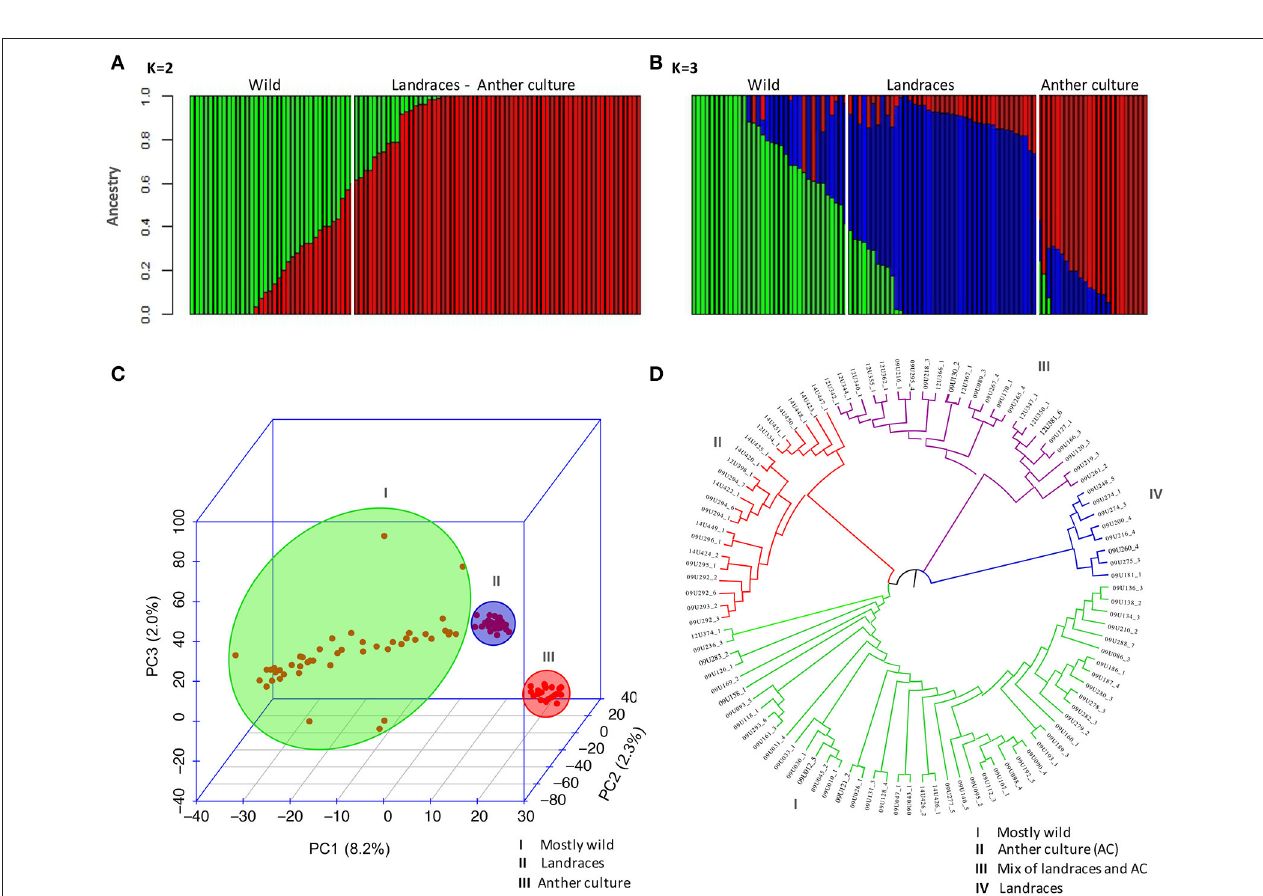
FIGURE 2 | Population structure of cape gooseberry collection based on 30,344 SNPs markers. Inferred population structure of the cape gooseberry collection using the tomato SNPs matrix. Bar plot for K = 2 (A) and K = 3 (B) grouped by state of cultivation and the bar length represent the membership probability of each accessions belonging to different sub-populations. (C) Scatterplot of Principal Component Analysis scores of components PC1, PC2 and PC3 based on 30,344 SNP markers. (D) NJ-based dendrogram with cape gooseberry SNPs clustered into four sub-populations. Colors correspond to each sub-population which consisted of: mostly wild accessions (I-green), mostly AC accessions (II-red), mix of CA accessions and landraces (III-violet), and only landraces (IV-red).